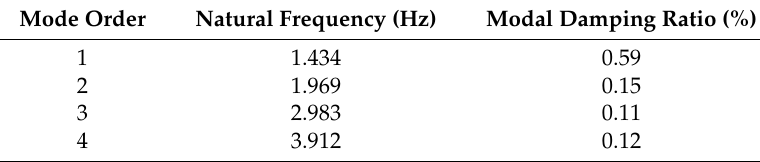
Table 2. Natural frequencies and modal damping ratios in the first four modes of an uncontrolled cable. Mode